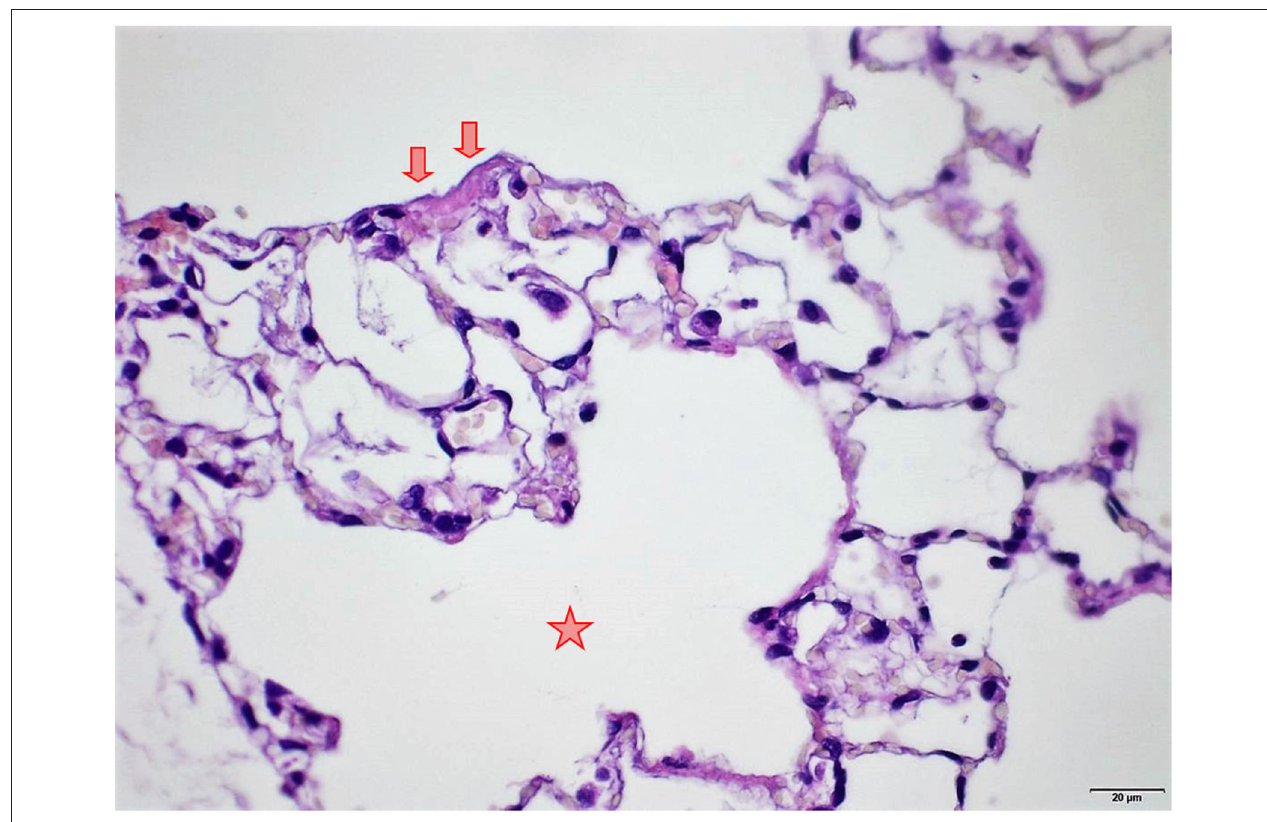
FIGURE 9 | Female rat. Deceased 1h. after transfer to cage. Lung, right middle lobe. Focal acute emphysema (asterisk) and focal alveolar wall necrosis (arrow). HE, original magnification x20.